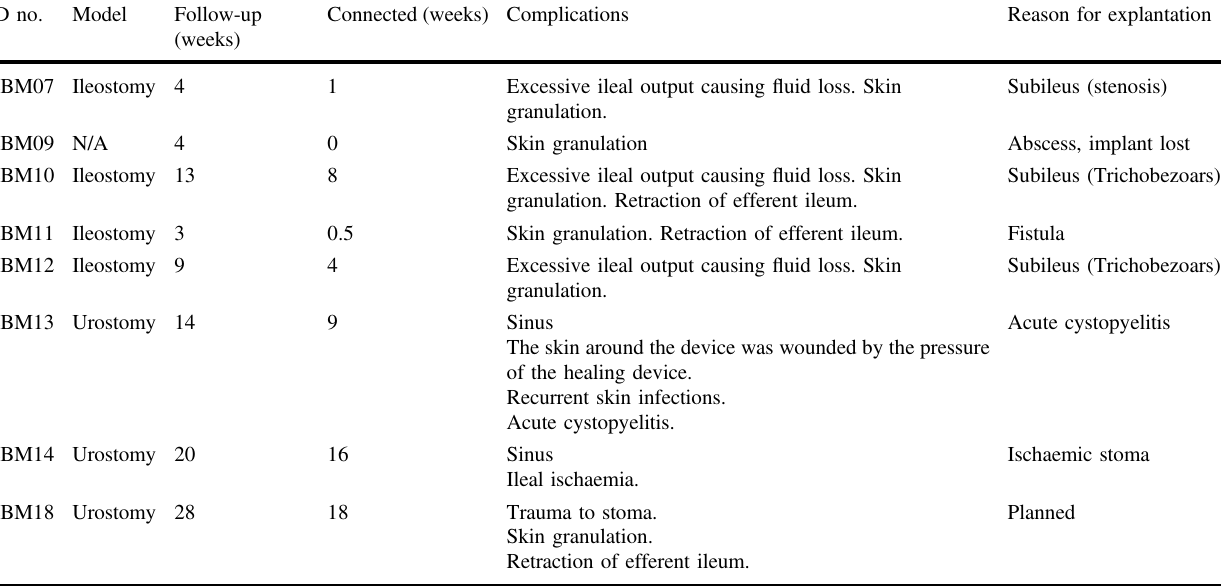
Table 1 Postoperative course and fi ndings at the time of autopsy ID